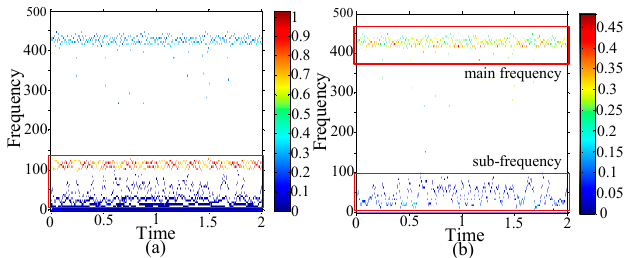
Figure 15. Healthy bearing ( a ) Hilbert–Huang transform (HHT) spectrum ( b ) GEMD-HHT spectrum.